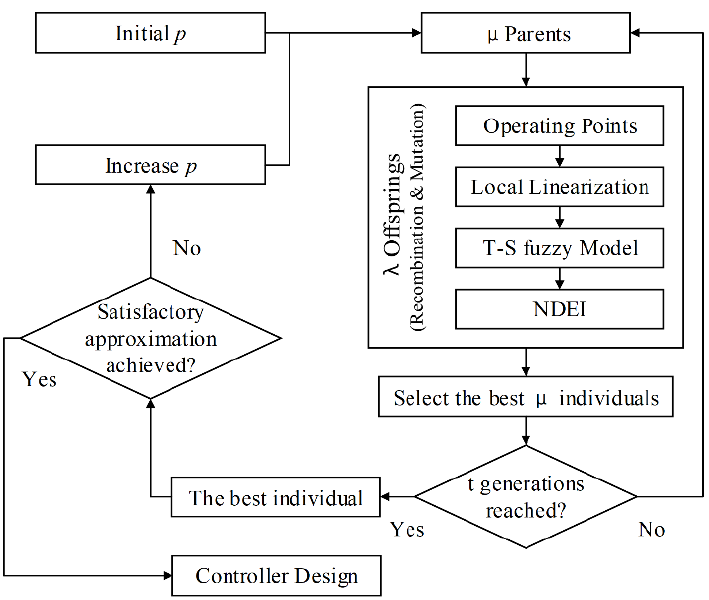
Figure 2. Evolutionary Strategy for selecting the operating points of linearization.